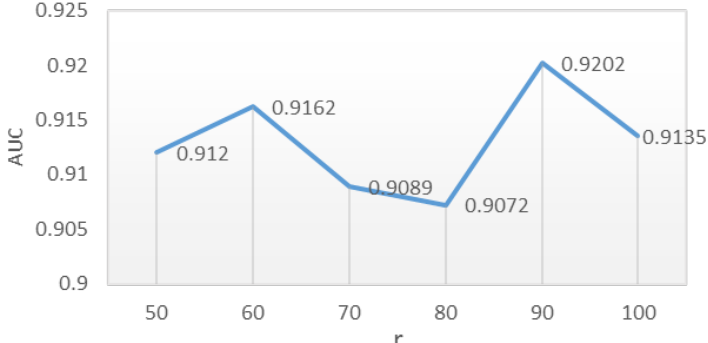
Figure 5. Influence of r on AUC value when α = 0.1, β = γ = 0.45, λ u = 1, λ v = 1.